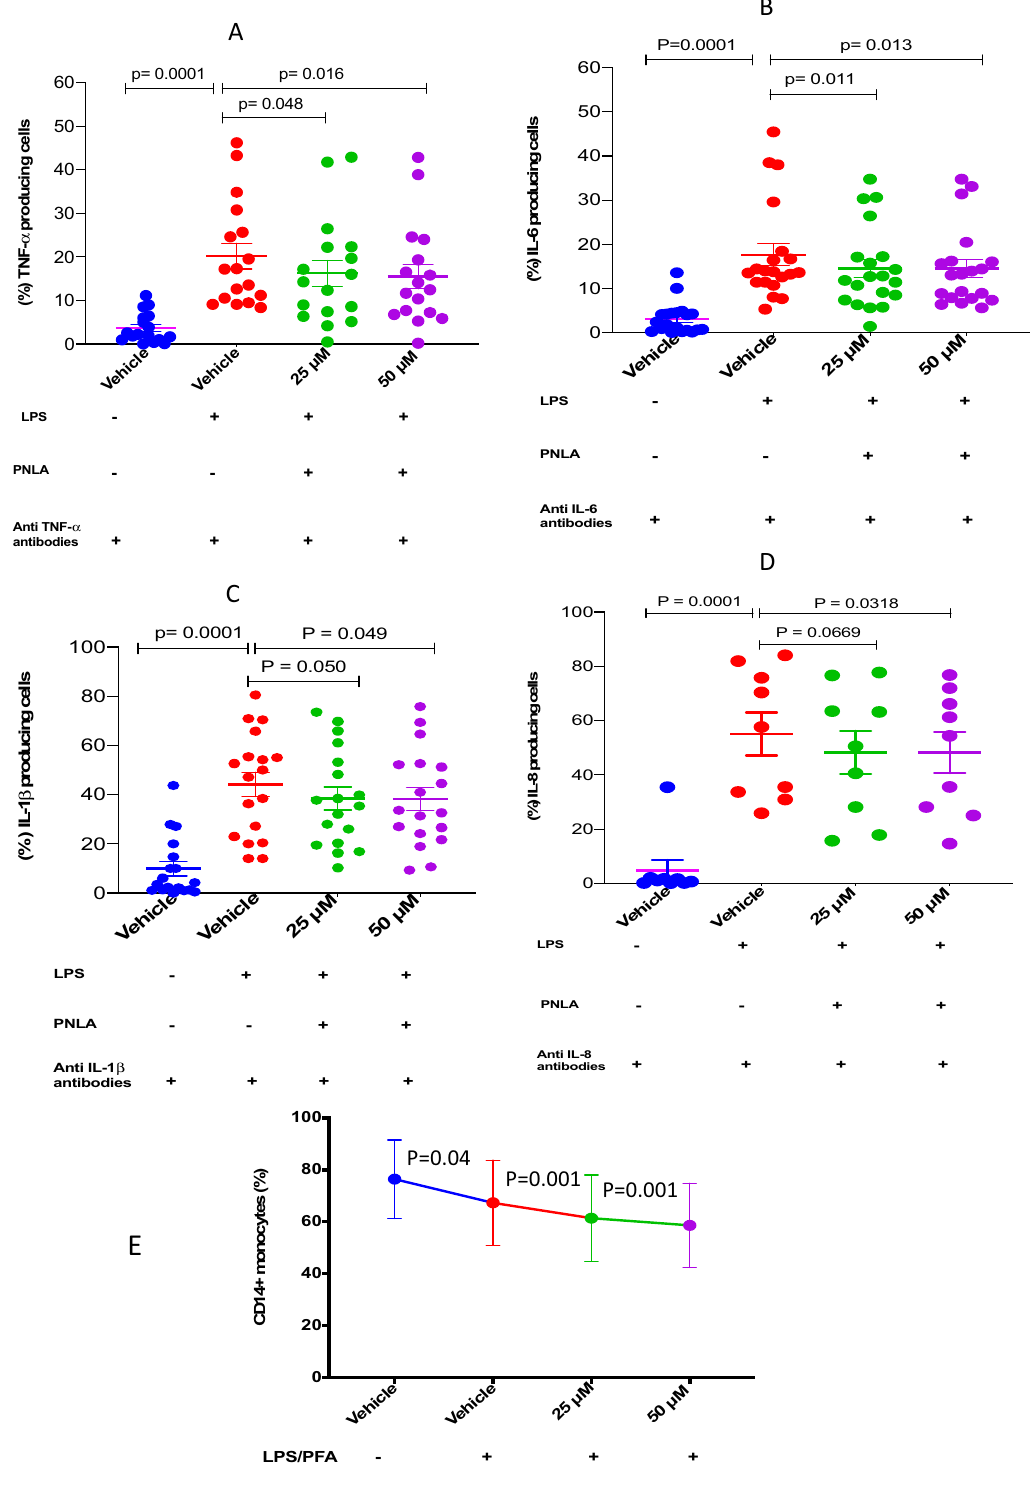
Figure 1. CD14 + monocytes expressing inflammatory cytokines were reduced significantly following PNLA treatment. TNF-α, IL-6 IL-1β, and IL-8 were reduced ( A – D ) respectively and PNLA at 25 or 50 µM reduced the percentage of monocytes ( E ). Purified monocytes were incubated with 25 or 50 µM PNLA for 24-h followed by 100 ng/ ml LPS stimulation for 9 h. Then, cells were stained and analysed for the expression of TNF-α, IL-6, IL-1β and IL-8 antibodies using flow cytometry; all samples run in duplicates or triplicates. The data are presented as mean ± SEM, each dot (•) represents the average of one participant. Statistical analysis was performed using one-way ANOVA